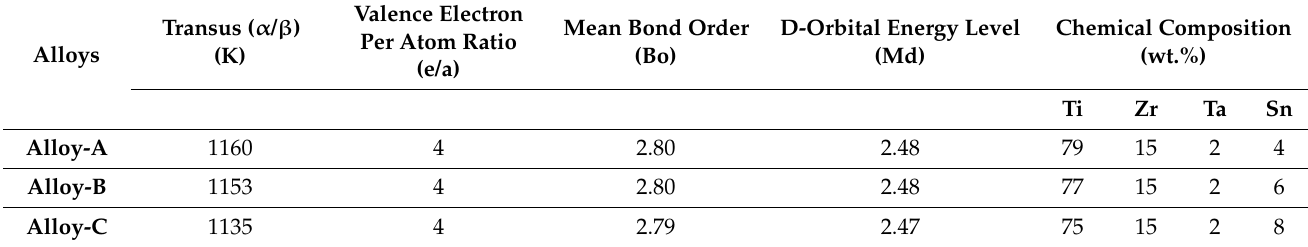
Table 1. The theoretical values and chemical compositions of the designed experimental